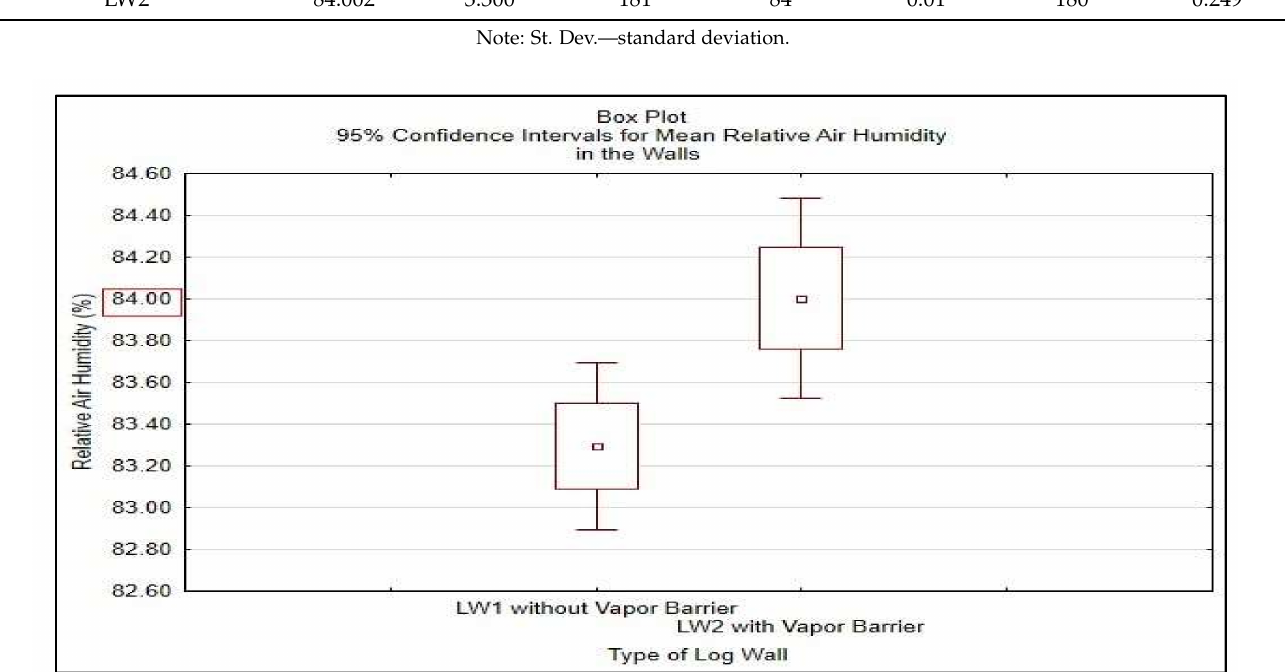
Figure 18. 95% Confidence Intervals for Mean Relative Air Humidity in the Walls in the